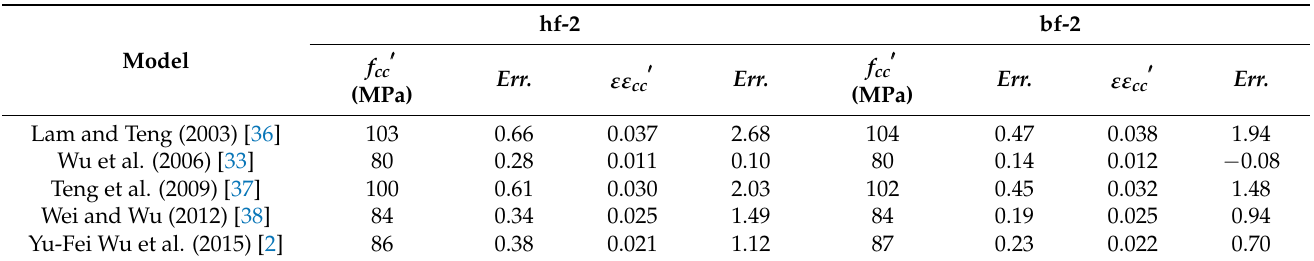
Table 5. Evaluation of existing models for predicting the ultimate stress and strain of cylinders with strain-hardening characteristics.